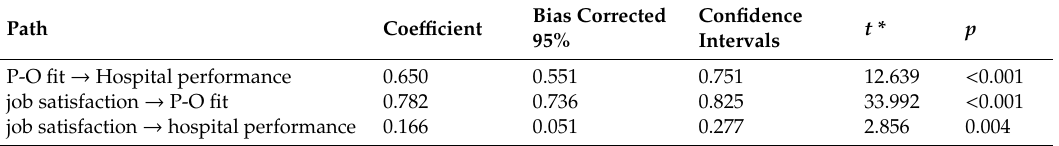
Figure 1. Mediating e ff ect of P-O fit (Person-Organization fit) on the link between job satisfaction and hospital performance. Table 4. Structural model assessment (PLS path model with